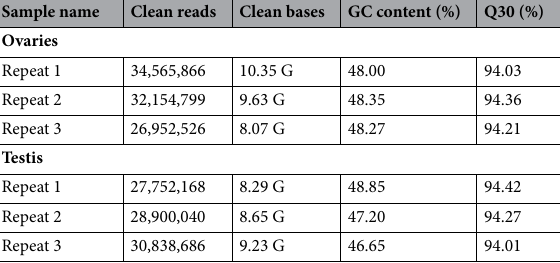
Table 1. Summary of the sequence assemblies according to the RNA-seq data of the A. dissimilis .